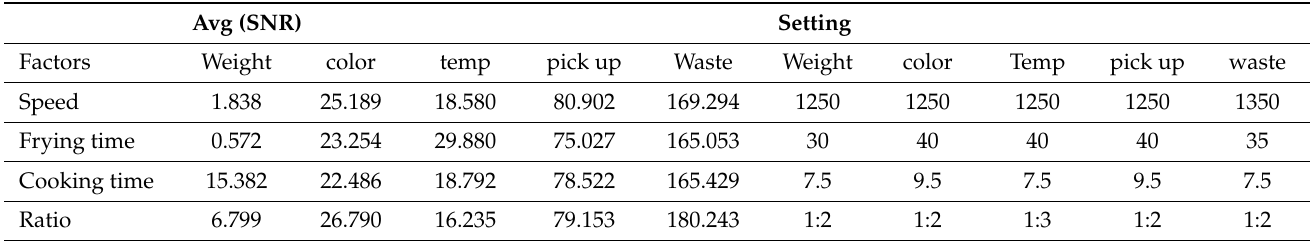
Table 16. Results for the optimization of a single